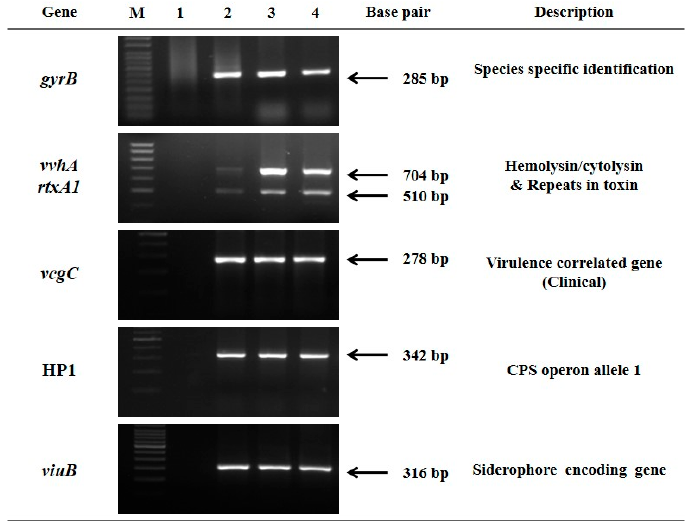
Figure 1. Agarose gel electrophoresis image showing PCR amplification of genes tested for V. vulnificus isolates. Lane M: Marker, Lane 1: Negative control, Lane 2: Positive control, Lane 3 and 4: Representative seafood isolates of V. vulnificus. Gel image was acquired using Gel Doc XR System and controlled by Image Lab Software (Bio-Rad, Hercules, CA, USA). A 50 bp DNA marker was used for gyrB gel electrophoresis and a 100 bp marker was used during electrophoresis of remaining amplicons.